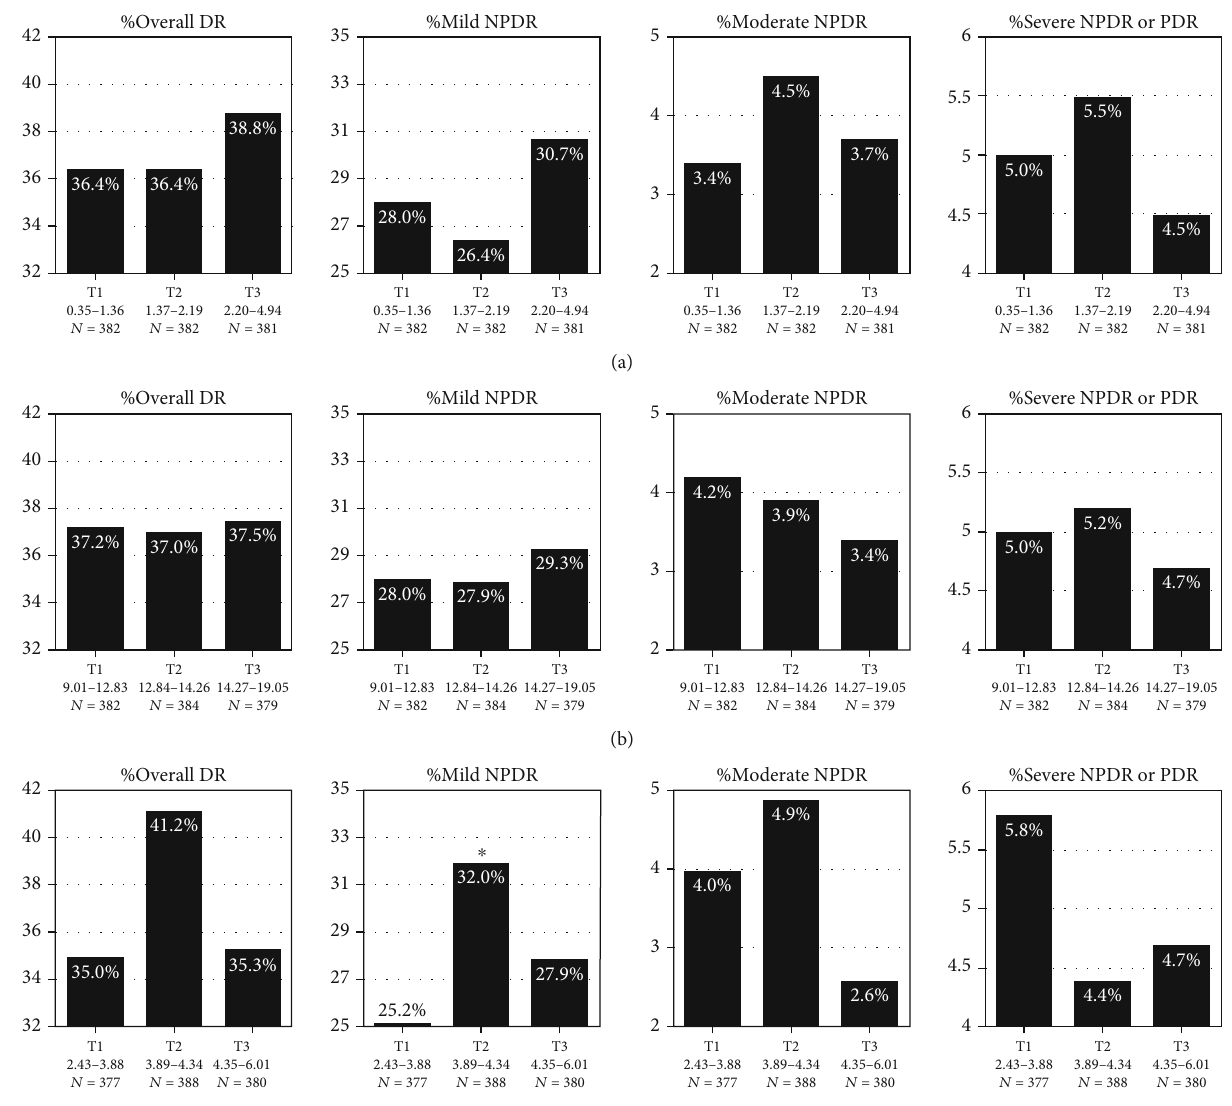
Figure 2: The variation of di ff erent stages of DR prevalence with serum TSH (a), FT4 (b), and FT3 (c). DR: diabetic retinopathy; NPDR: nonproliferative diabetic retinopathy; PDR: proliferative diabetic retinopathy; TSH: thyroid-stimulating hormone; FT4: free thyroxine; FT3: free triiodothyronine. The strati fi cation of the thyroid indicators is stated in the fi gure, and the unit of TSH, FT4, and FT3 should be mU/L, pmol/L, and pmol/L, respectively. The ∗ indicates that the corresponding prevalence was signi fi cantly higher than the control group (T1) ( p < 0 : 05